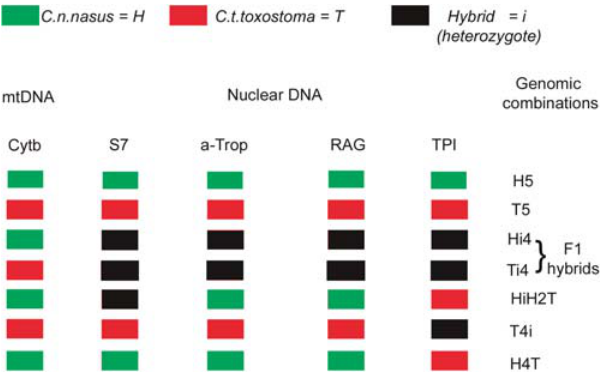
Figure 1. IDENTIFICATION CODE. Some examples of genomic combinations based on the alleles for each of the five molecular markers (1 mitochondrial gene and 4 nuclear introns).